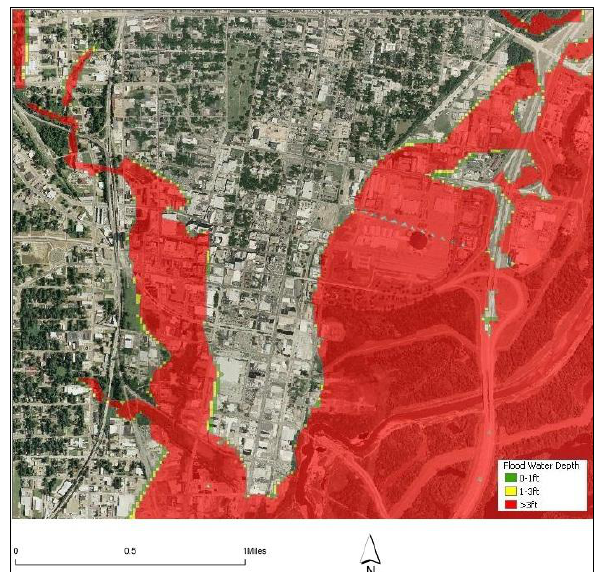
Figure 20. Inundation on I-55 near downtown